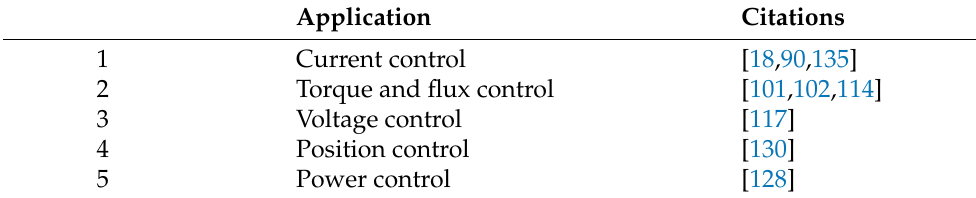
Table 3. Predictive control strategies applied to DMCs.